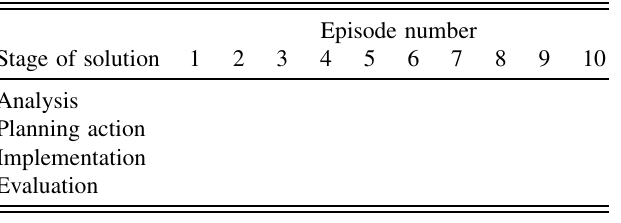
TABLE I. Mapping episodes to steps in the pedagogical problem-solving